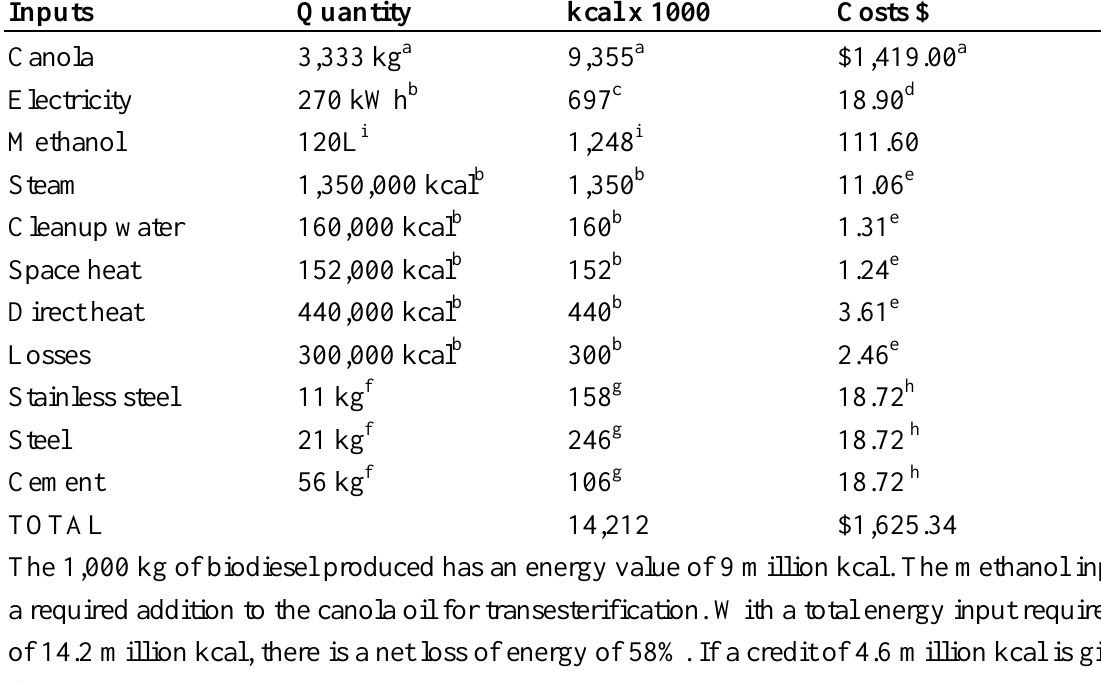
Table 11. Inputs per 1,000 kg of biodiesel oil from